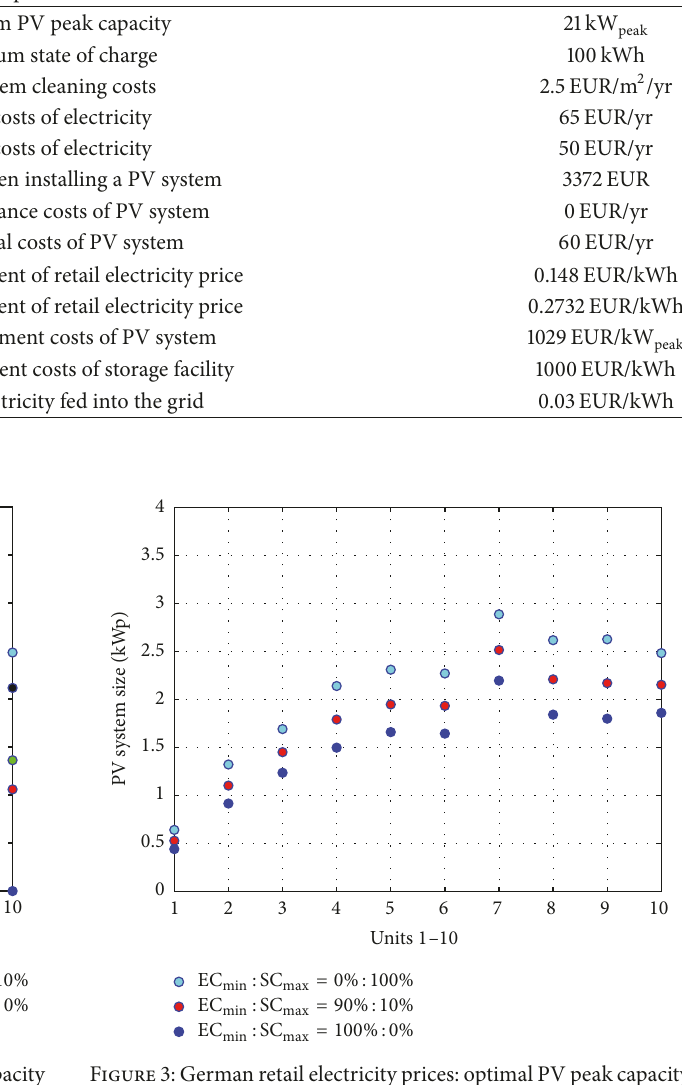
Figure 3: German retail electricity prices: optimal PV peak capacity for the individual apartments calculated for different weighting of objective